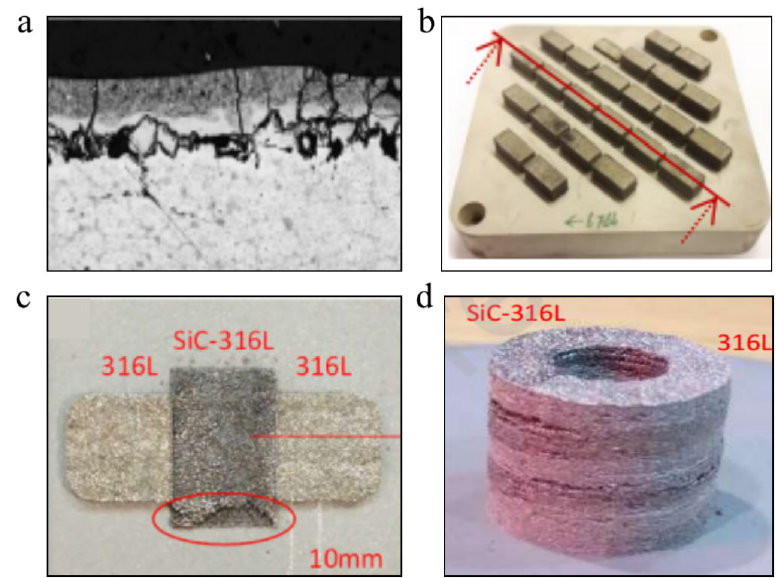
Fig. 13 SLM and LPBF of SiC ceramic: (a) SLS of SiC coating. Reproduced with permission from Ref. [52], © Elsevier Ltd and Techna Group S.r.l. 2018. (b) LPBF of SiC–Mg metal matrix composite. Reproduced with permission from Ref. [53], © The Author(s) 2019. (c) LPBF of SiC–316L metal matrix composite. Reproduced with permission from Ref. [54], ©